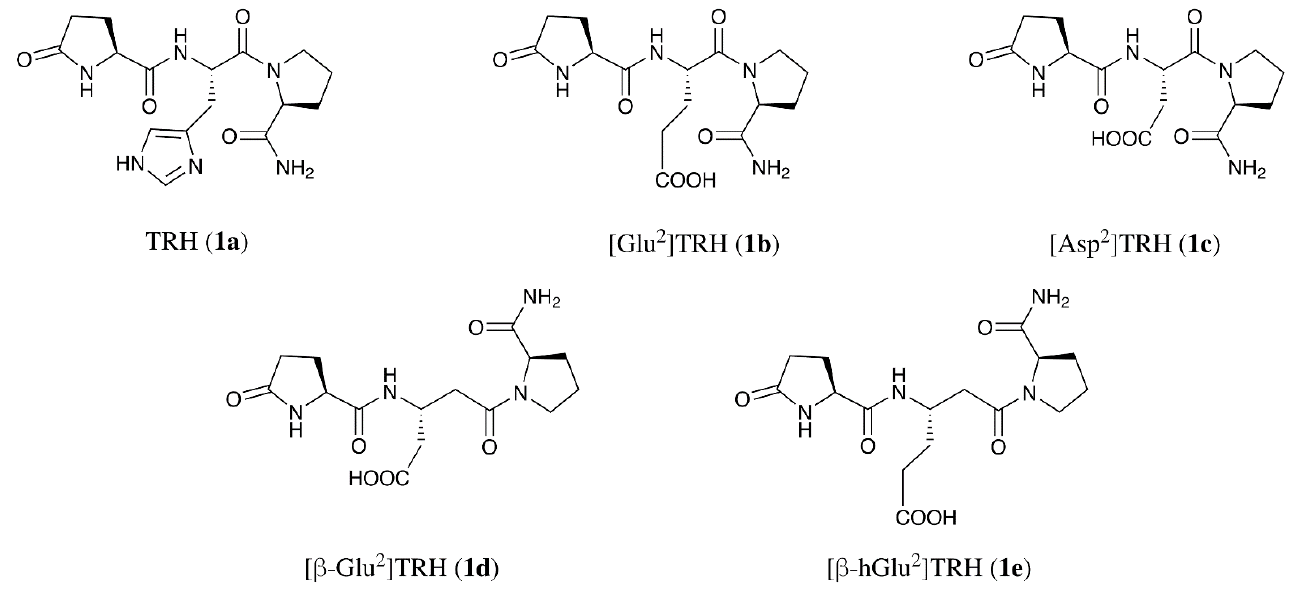
Figure 1. Chemical structure of thyrotropin-releasing hormone (TRH) ( 1a ), [Glu 2 TRH ( 1b ), and the evaluated [Glu 2 ]TRH-like pep- tides: [Asp 2 ]TRH ( 1c ), [β -Glu 2 ]TRH ( 1d ), and [β -hGlu 2 ]TRH ( 1e ). Structures as shown represent the central residues in an L-configuration.